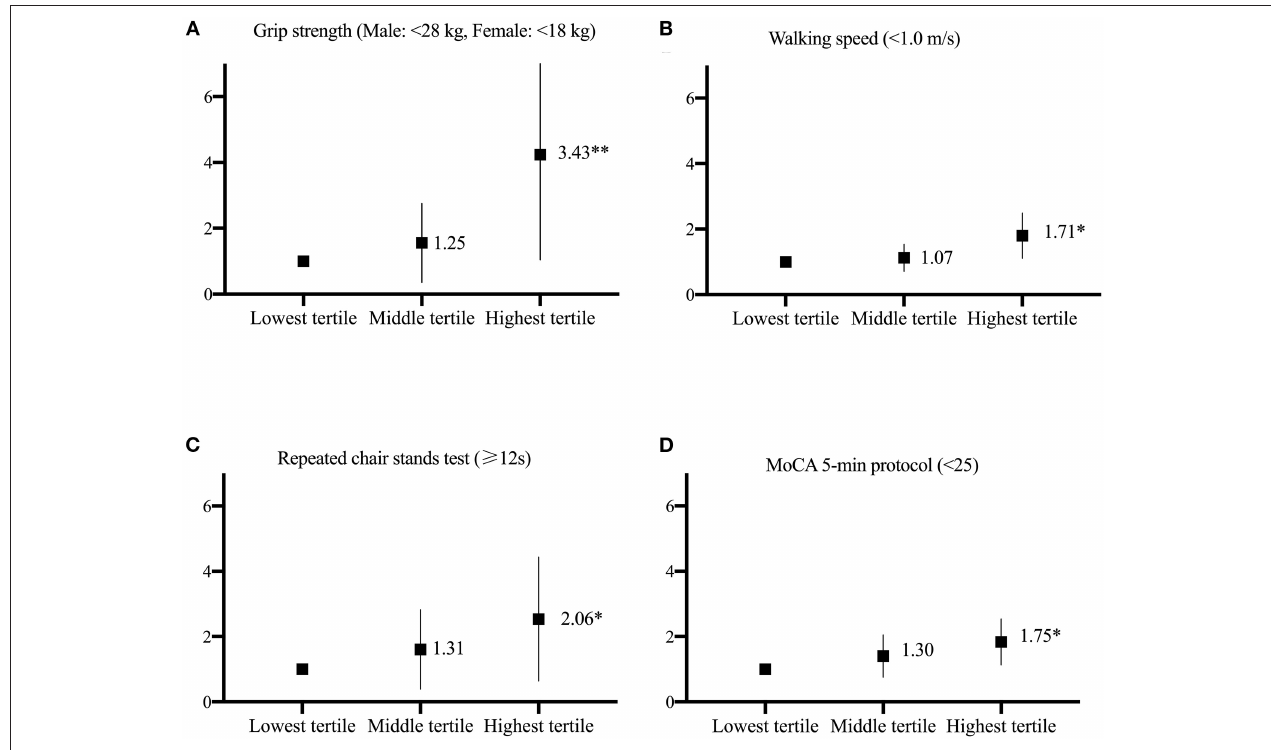
FIGURE 1 | The relationship between the different tertiles of urinary 8-oxoGsn and physical and cognitive function is represented (A–D) . Odds ratio and 95% CI derived from logistic regression models after adjusting for age, sex, smoking habits, alcohol consumption, hypertension, diabetes, cerebrocardiovascular disease, and chronic kidney disease. The lowest tertile of urinary 8-oxoGsn was used as the reference group * p < 0.05, ** p <